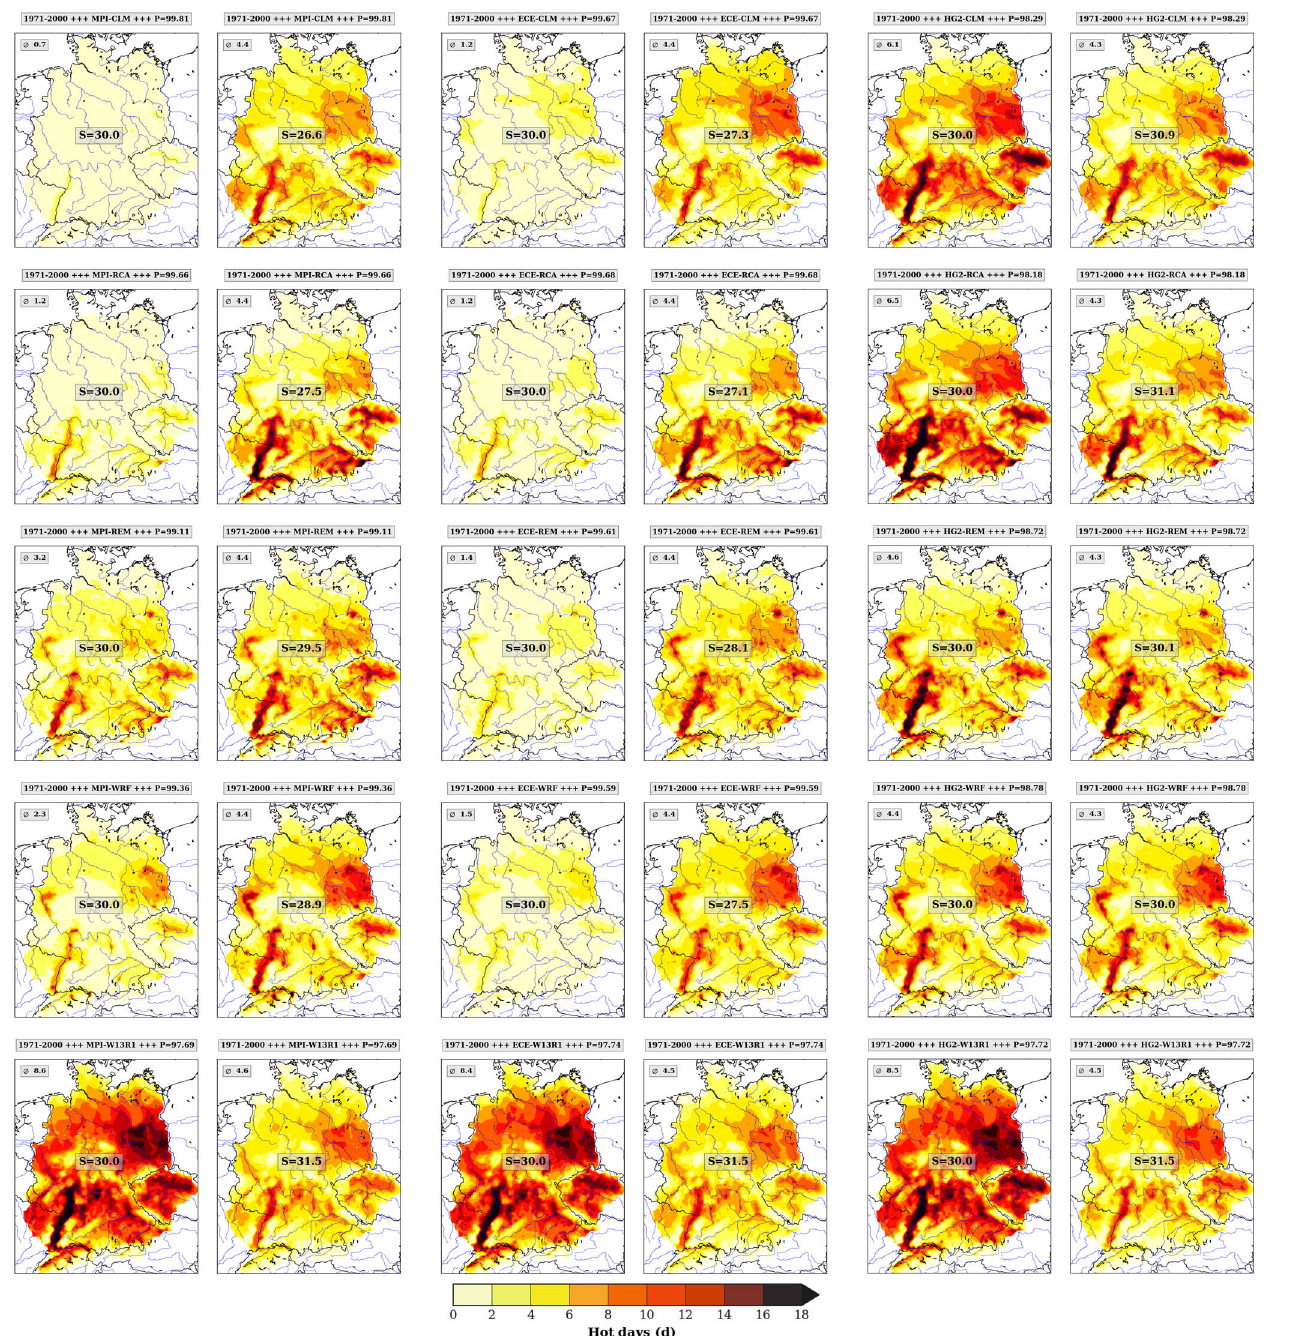
Figure 3. Comparison of su30 (hot days with a maximum above 30 ◦ C) regionalizations using 20C/historical runs data from the period 1971–2000. The forcing GCMs are arranged in columns and the RCMs in rows. Each row contains three pairs of maps for the three GCMs used, showing su30 without (left) and with (right) bias